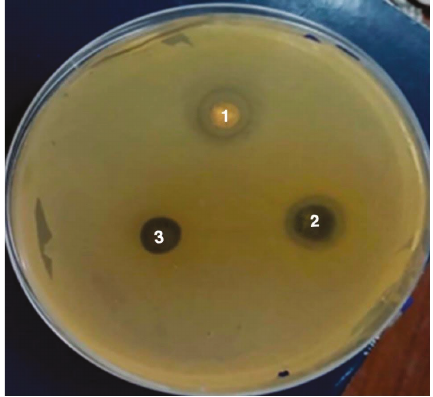
Figure 24: Microbiological activity against Salmonella typhimurium